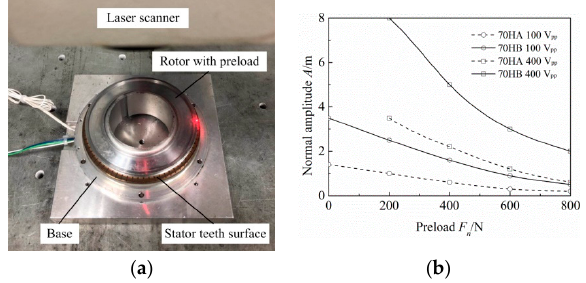
Figure 13. Normal amplitude test of the stator teeth surface with preload: ( a ) photograph of the experiment and ( b ) effect of preload and excitation voltage on the normal amplitude.